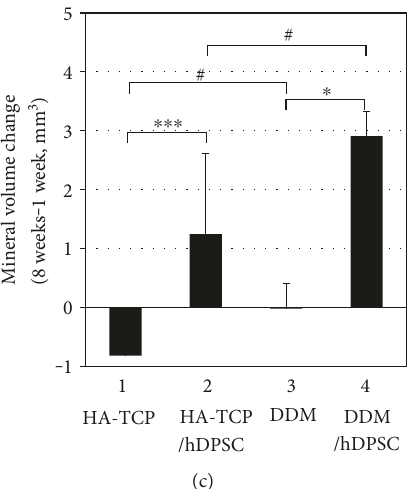
Figure 4: Ectopic bone-forming e ffi cacy of hDPSCs transplanted with HA-TCP or DDM in athymic nude mice. Bone formations in the transplantation of HA-TCP (a) and DDM (b) were analyzed by micro-CT. The results were shown as X-ray images (A) and 3D- visualization image (B). (c) Quanti fi cation of mineral volume change over 1 week and 8 weeks. 1, transplantation of HA-TCP only; 2, transplantation of HA-TCP with hDPSCs; 3, transplantation of DDM only; 4, transplantation of DDM with hDPSCs. Statistical analyses were carried out using Student ’ s t test. ∗ p < 0 05 ; ∗∗∗ p < 0 001 ; #, signi fi cant di ff erence not be